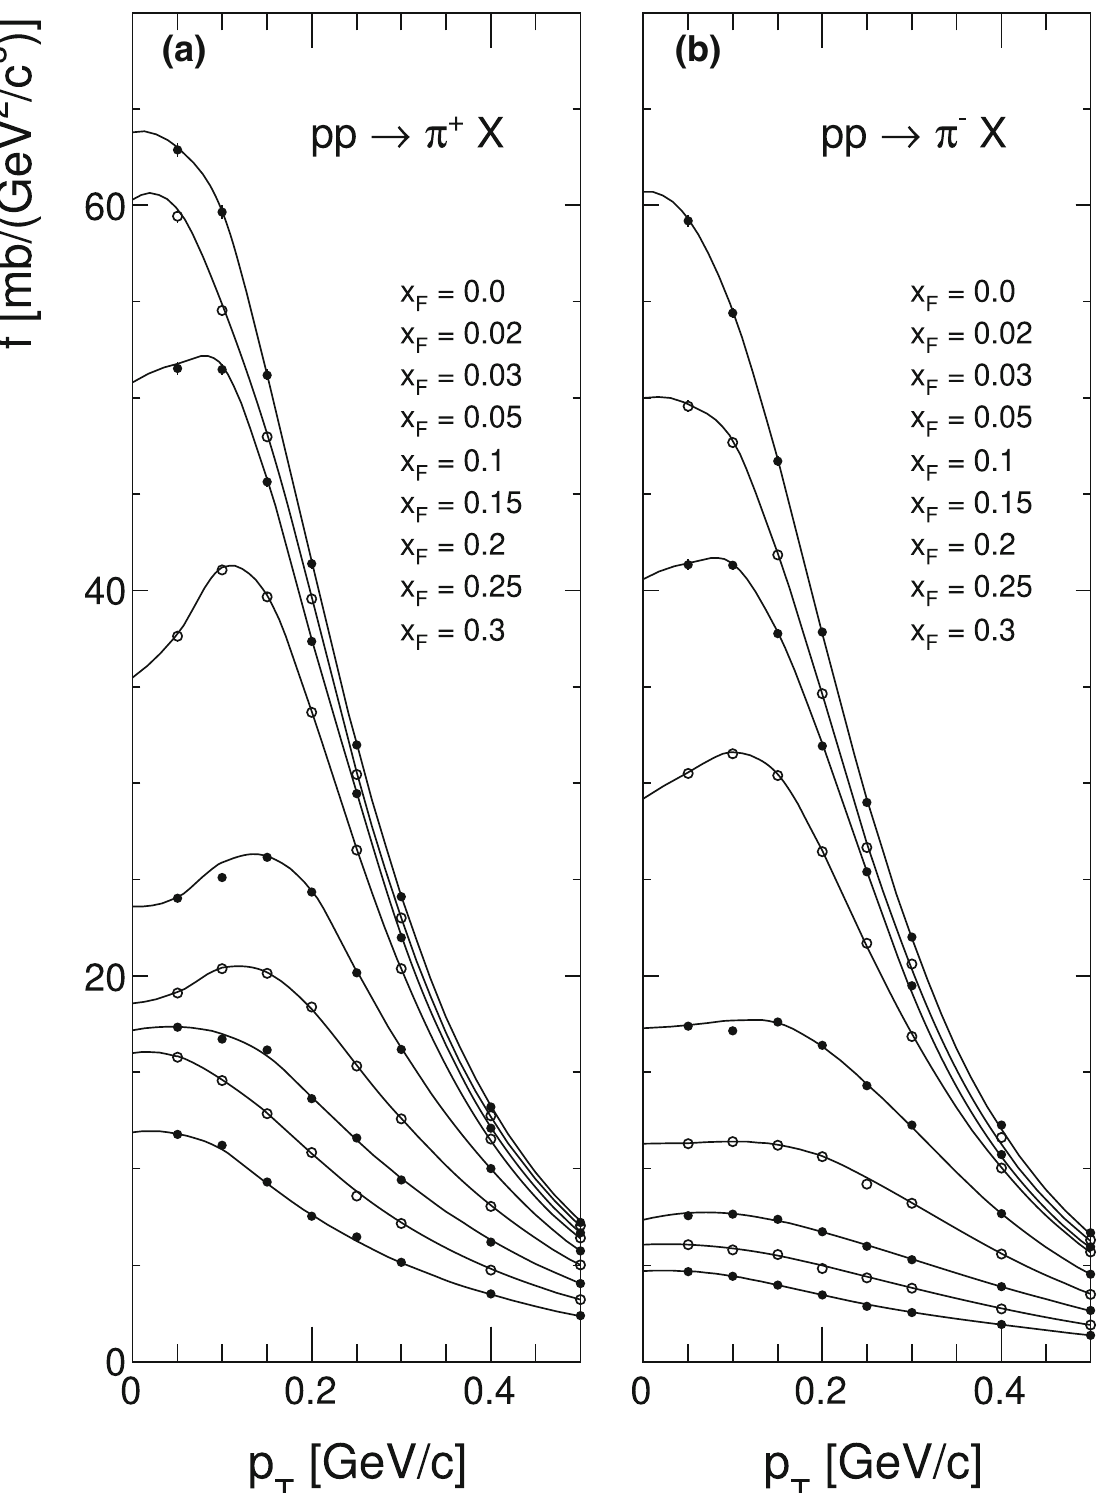
Fig. 84 Invariant cross section at low transverse momenta as a function of p T at fixed x F for a π + and b π − produced in p+p collisions at 158 GeV/c